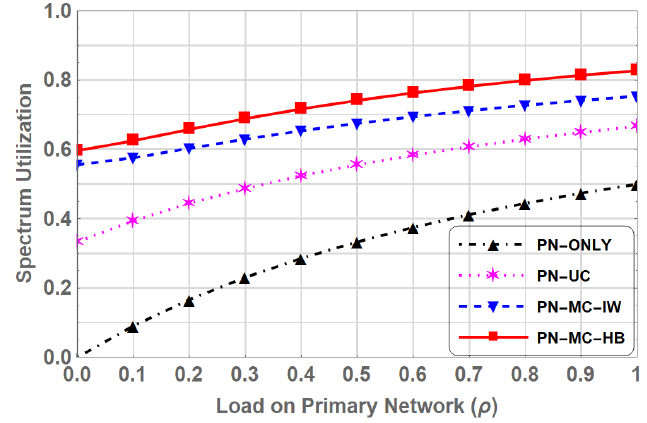
Figure 13. Comparison of Spectrum Utilization for PN-ONLY, PN-UC, PN-MC-IW and PN-MC-HB.